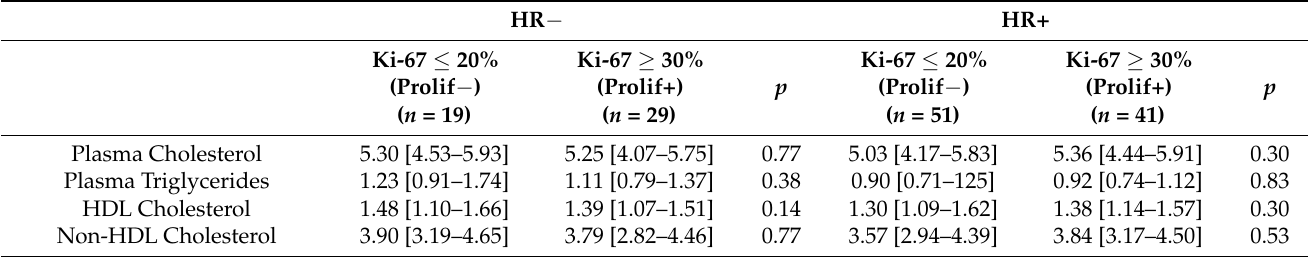
Table 2. Whatever the hormonal status and the level of Ki-67 expression of breast tumor, the lipid parameters of the patients were comparable and close to normal range. Table 2. Circulating lipids (mmol/L) according to the subgroups of patients.